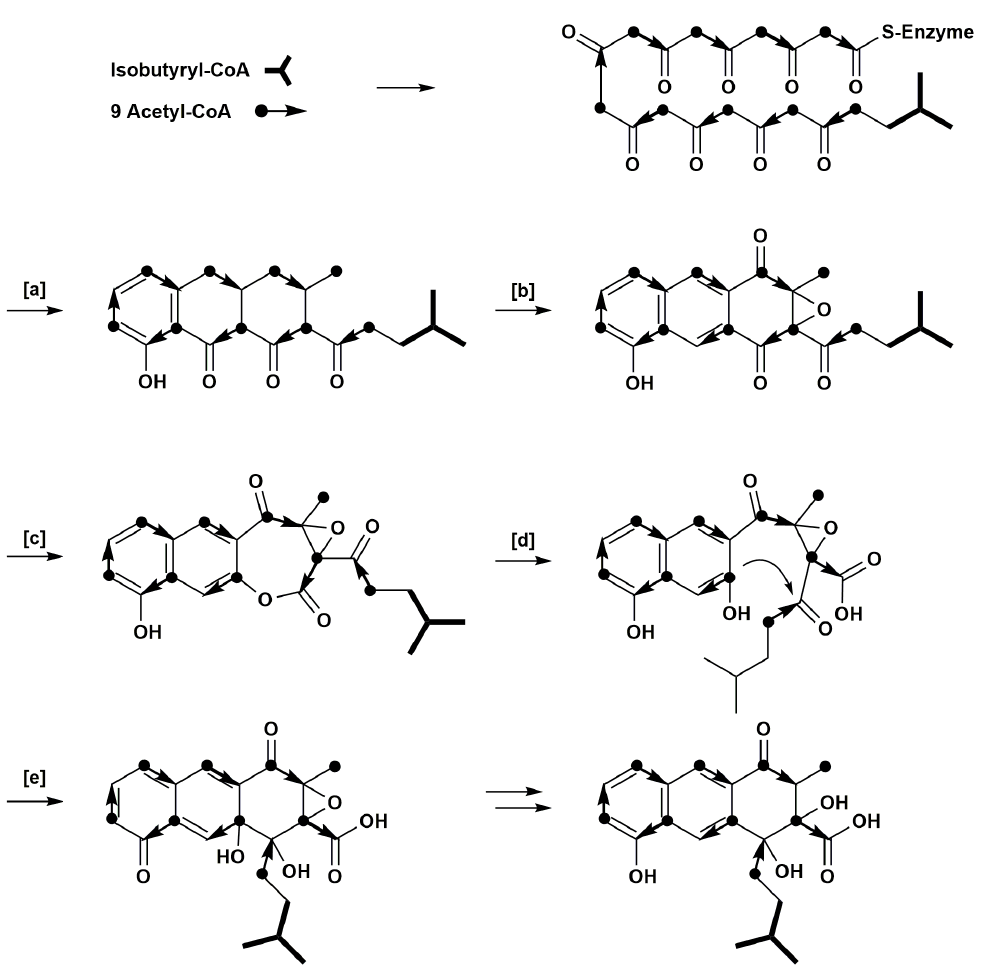
Figure 3. Proposed pathway of rishirilide B biosynthesis. ( a ) cyclisation and decarboxylation; ( b ) aromatization, oxidation; ( c ) Bayer-Villiger oxidation; ( d ) hydrolytic ring opening; ( e ) aldole